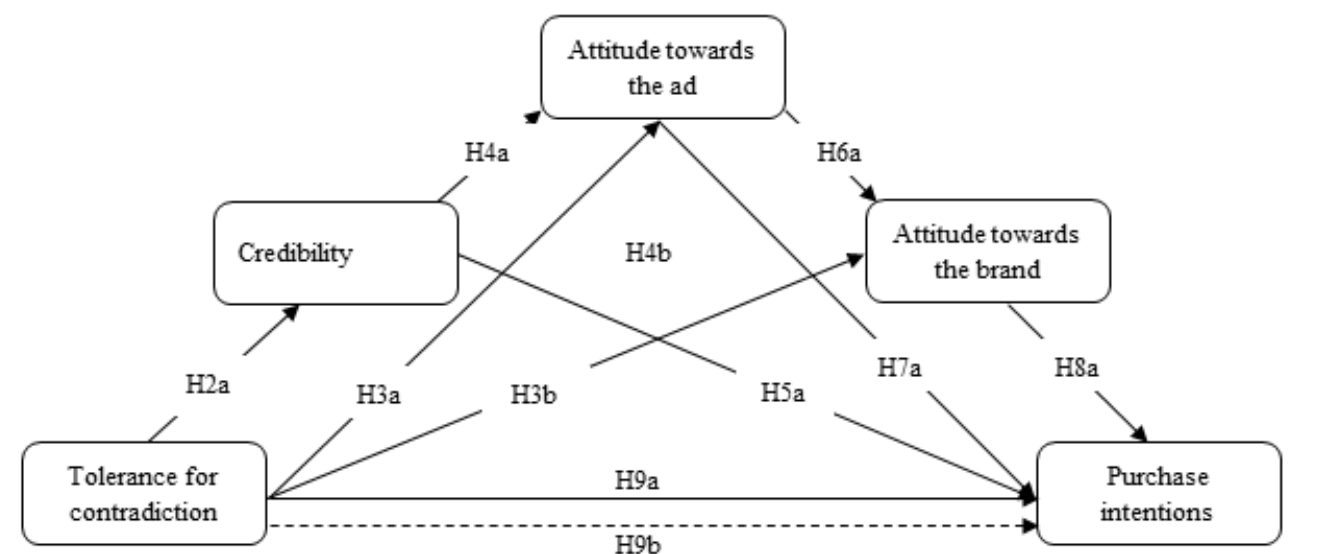
Figure 3. Conceptual model.